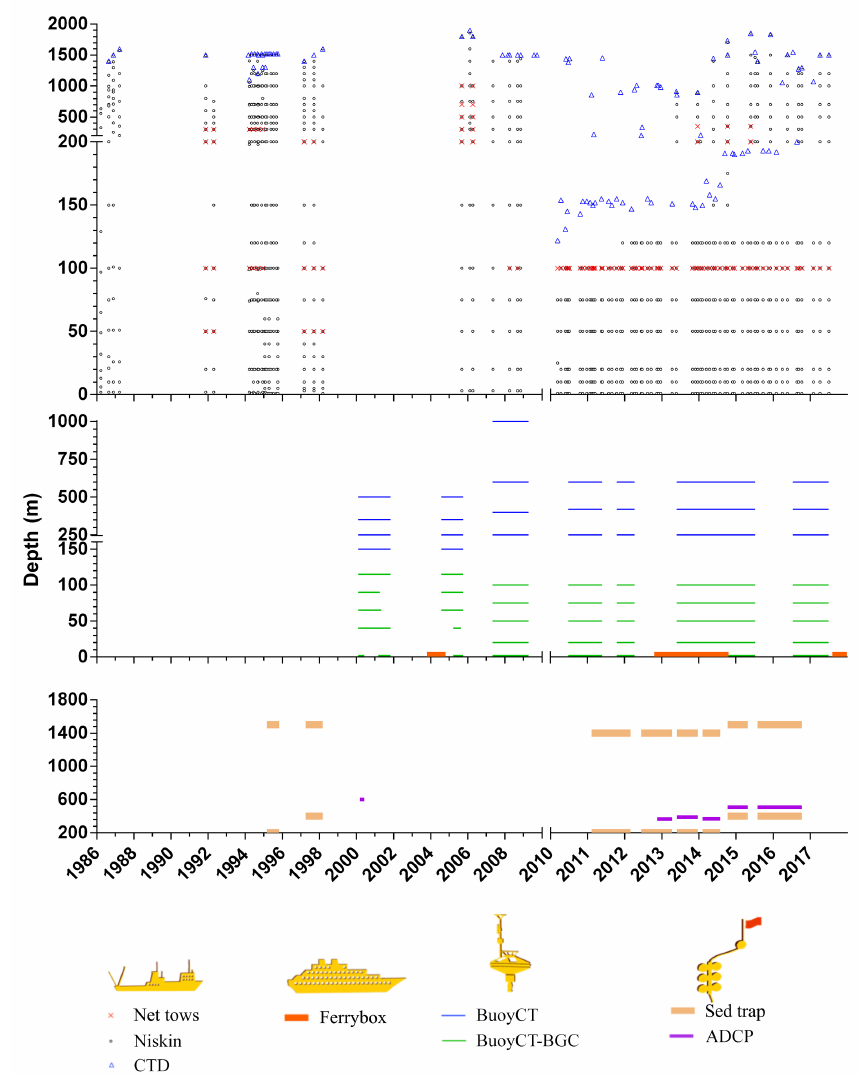
Figure 5. Periods of operation of the different platforms located in the open Cretan Sea (historical metadata within a circle of 20 nautical miles radius around the position of E1-M3A; exclusion of metadata made within 10 nautical miles from a coast). Before 2010, the metadata listed may not be exhaustive. Conductivity–temperature–depth (CTD) casts and net tows were made from the surface to the depth shown in the figure. Ferrybox entry point is located at 3m depth. BGC: O 2 and/or fluorescence sensors. CT: conductivity and